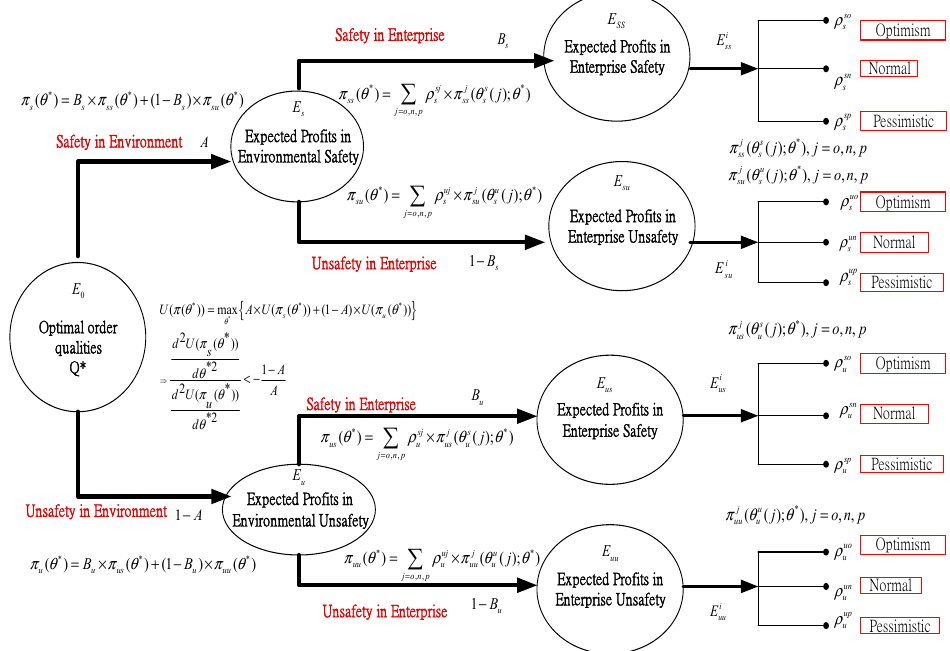
Figure 1. The optimal order quantity framework of the food safety problem under the condition of environmental and corporate uncertainty.